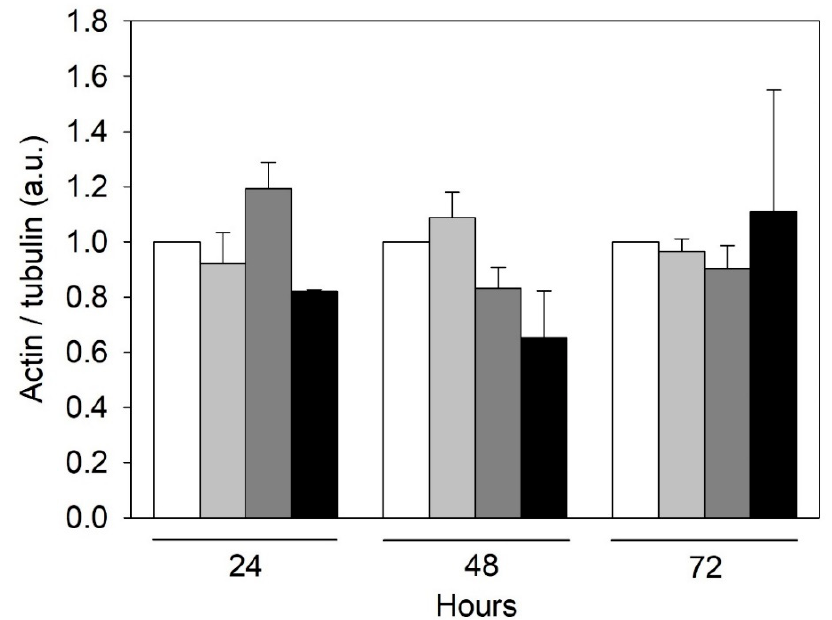
Figure 3. Effect of urea on the actin amount in HMEC-1. Histograms showing the actin level measured in control cells and cells treated with 0.25, 2, or 5 g/L urea for 0, 24, 48, or 72 h. Tubulin was used as a housekeeping protein. Data are expressed as the mean ± SD. * p < 0 05.